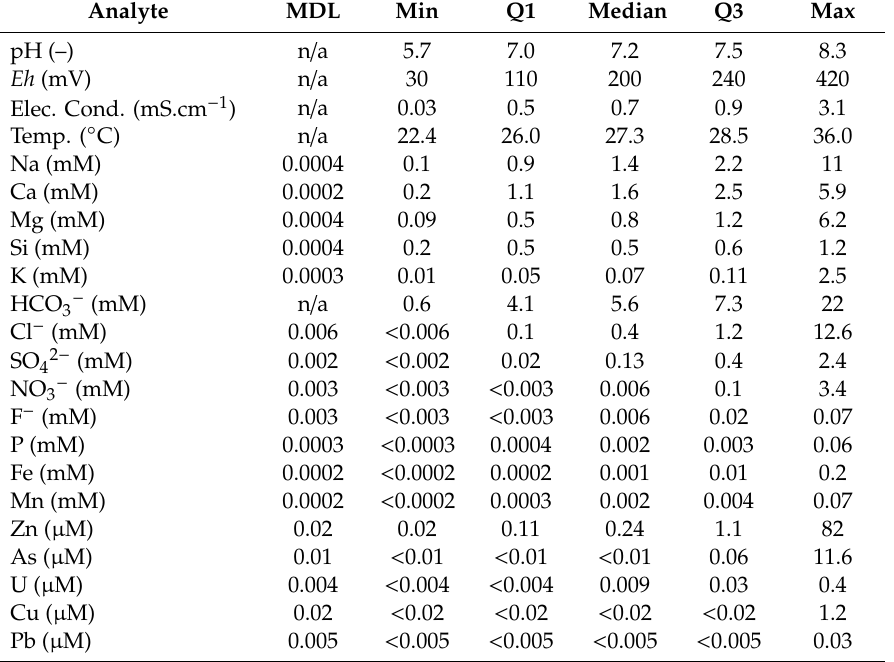
Table 1. Summary statistics for geochemistry of Bihar groundwater; MDL = method detection limit; Q = quartile; n / a = not applicable. Samples with measured concentrations below detection for a particular analyte are included as zero in summary statistic